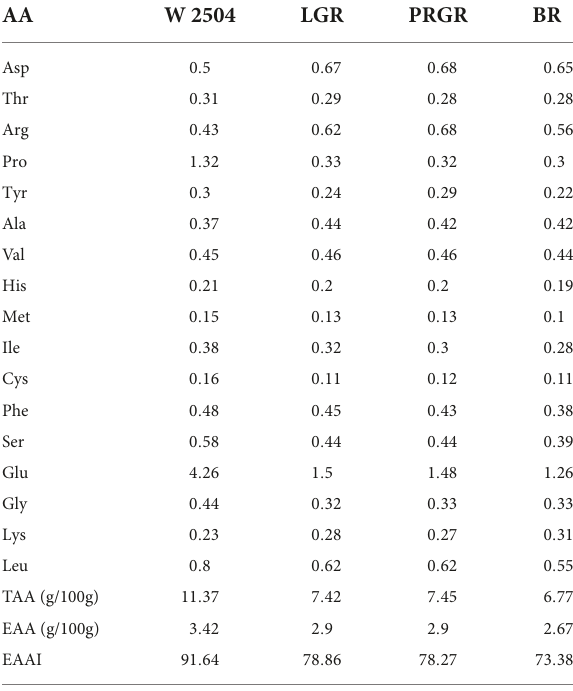
TABLE 2 Amino acid composition of different rice and common wheat (g/100